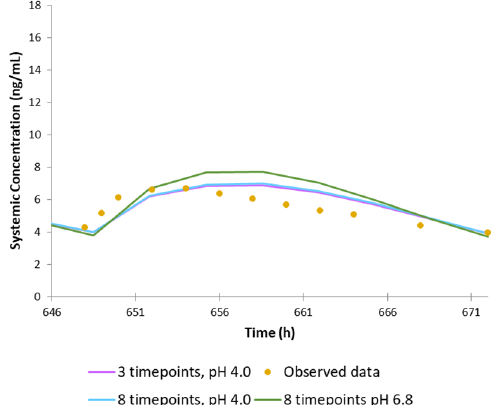
Figure 4. Mean observed (circles) and simulated (solid line) systemic plasma concentration–time profiles of ropinirole (5%th and 95%th percentiles are presented as grey dashed lines). Simulations of GSK study No. 112771 (2 mg, Aranda site) and study No. ROP109087 (4 mg) with the use of in vivo clearance obtained by interspecies scaling.